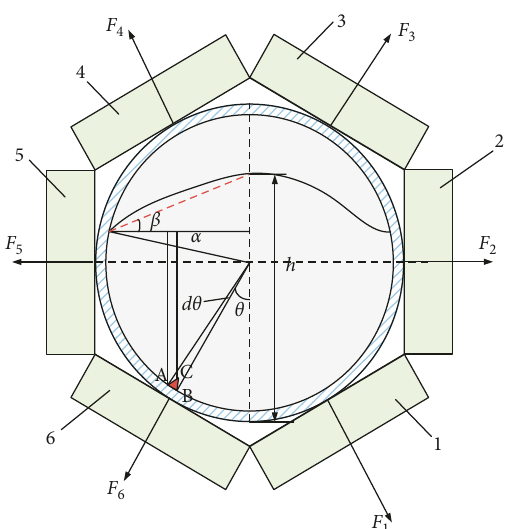
Figure 2: Clip-type bottom roller material element